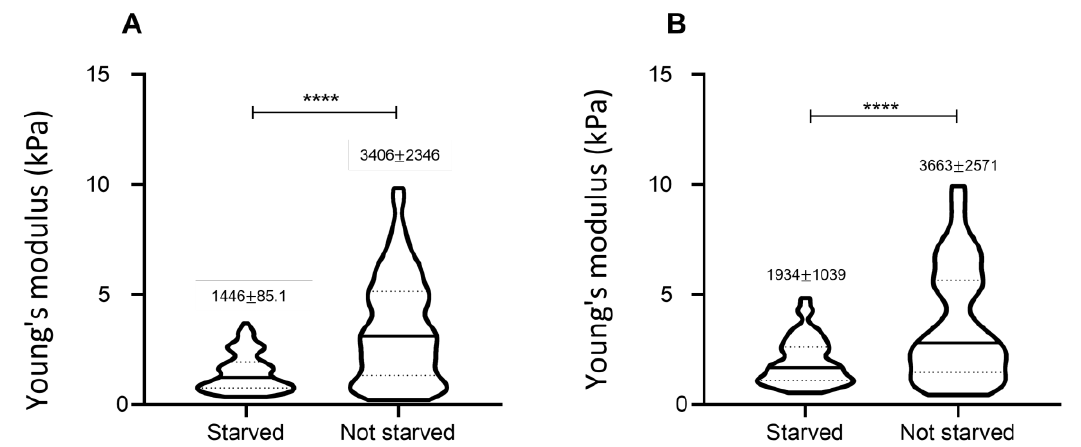
Figure 13. Effect of starvation. Two independent experiments comparing starved and non-starved cells from the same fibroblast line obtained from different cryotubes at the same cell passage (FB line 1, panels ( A ) and ( B )). Each value of the distribution represents the Young’s Modulus from an individual cell. For each distribution, the average value and the standard deviation are reported. The statistical comparison was performed by means of the non-parametric Kolmogorov–Smirnov test. In both cases, the difference was statistically significant (**** p < 0.001).